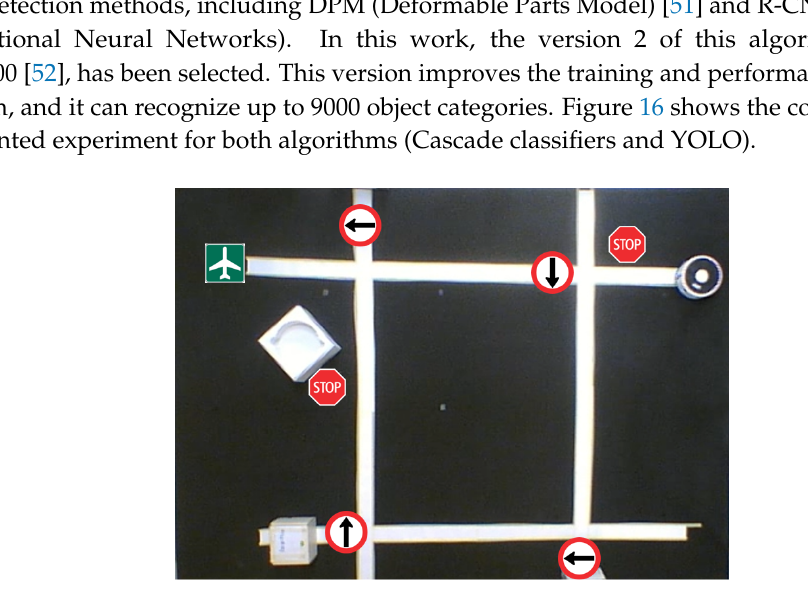
Figure 16. Experimental setup for the real